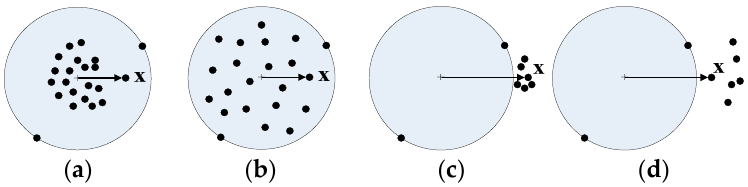
Figure 4. Four different types of samples distribution inside/outside the hypersphere. ( a ) Type 1, most samples are more condensed to the center of the hypersphere; ( b ) Type 2, samples distribute more randomly over the hypersphere; ( c ) Type 3, some samples outside the hypersphere are more condensed; ( d ) Type 4, samples outside the hypersphere distribute more randomly.